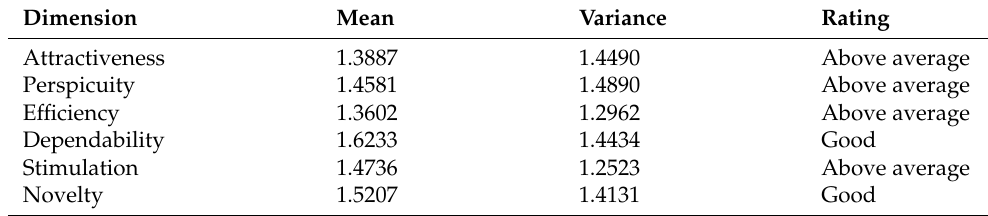
Table 6. Summary of UEQ dimensions.